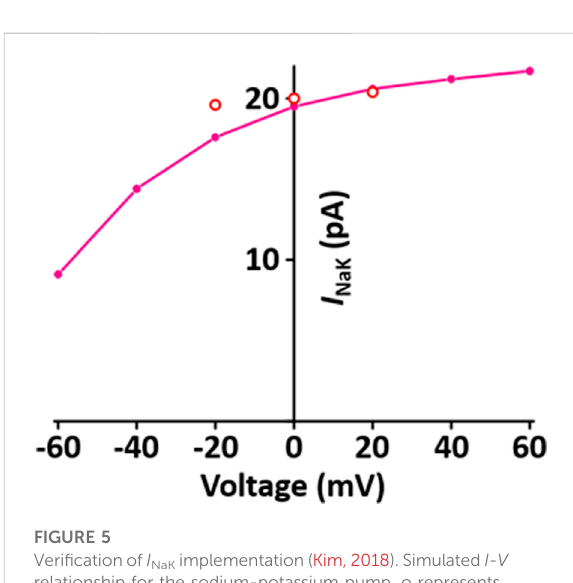
FIGURE 5 Veri fi cationof I NaK implementation (Kim, 2018).Simulated I-V relationship for the sodium-potassium pump. o represents experimental data from Stimers and Dobretsov,